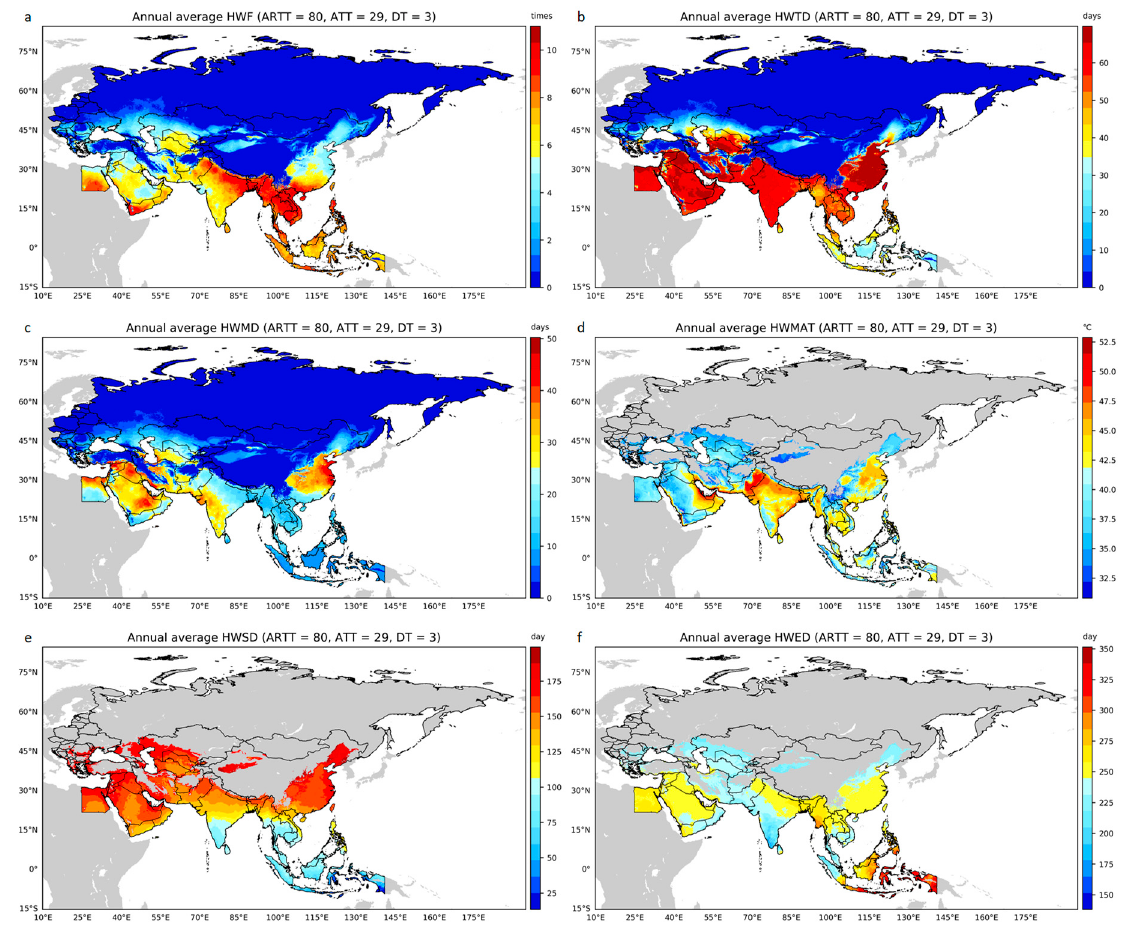
Figure 7. Annual average value of: ( a ) HWF; ( b ) HWTD; ( c ) HWMD; ( d ) HWMAT; ( e ) HWSD; ( f ) HWED.